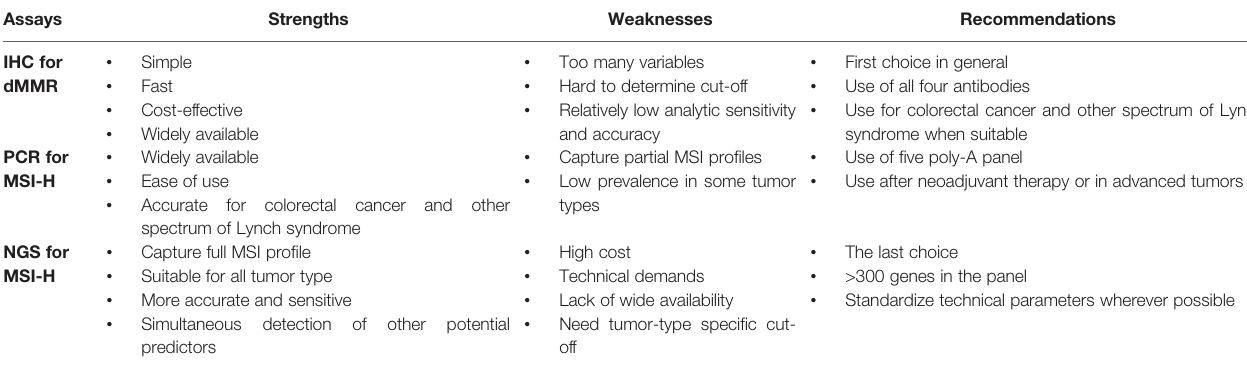
TABLE 3 | Strengths, weaknesses and recommendations for three predictive MSI-H/dMMR biomarkers for ICI response. Assays